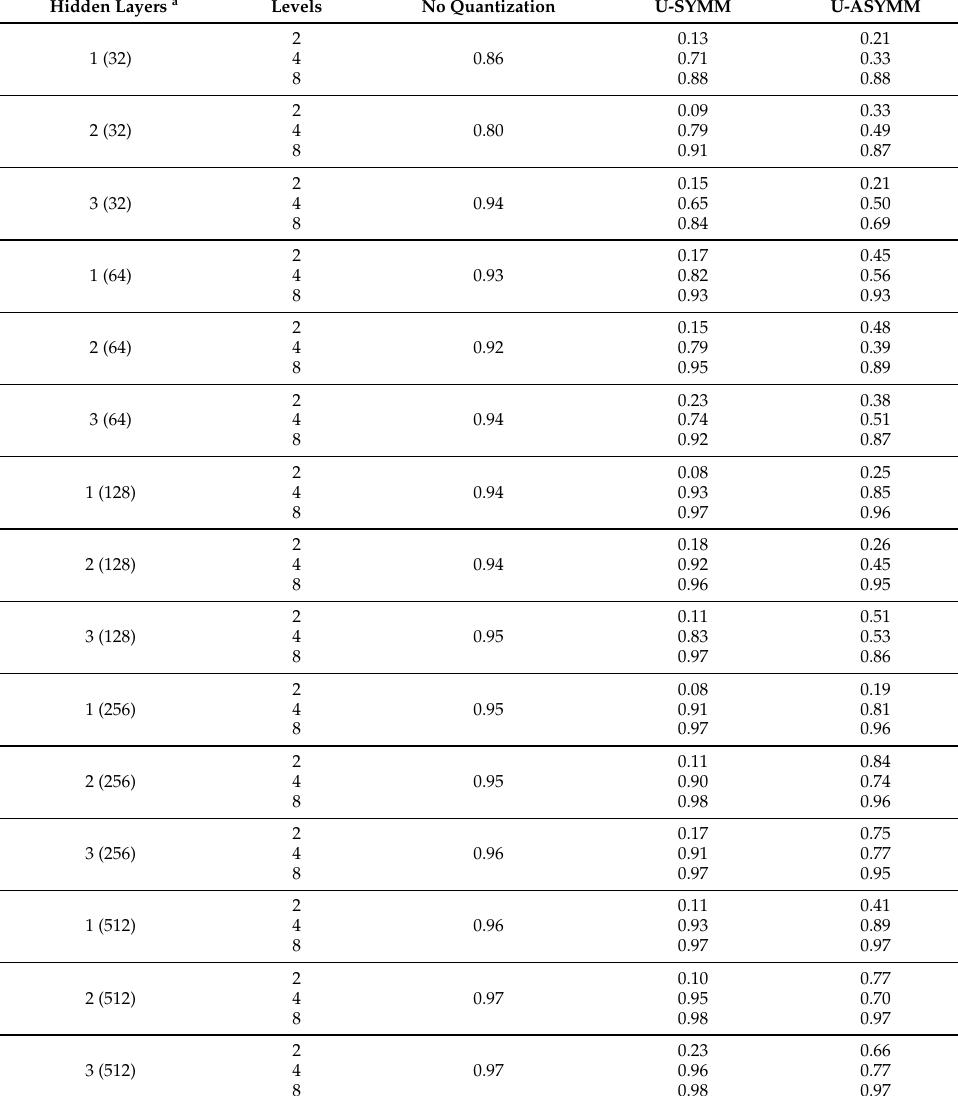
Table 6. Balanced accuracies obtained on each class on the test set for the different parameters set. Hidden Layers a